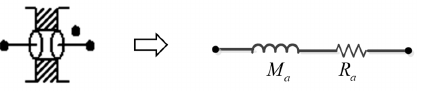
Figure 4. Cavity and hole in dynamic speaker unit.